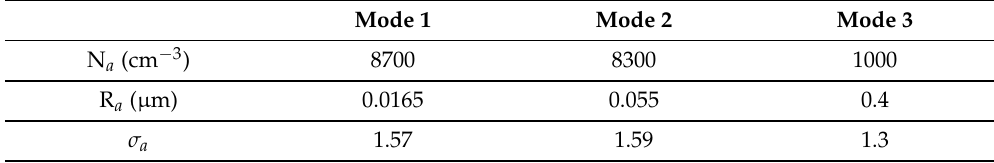
Table 2. Aerosol size distribution characteristics at 2100 (UTC) during IOP 13 used in the control simulation. N a is the number of particles, R a is their dry radius and σ a is the standard deviation of the log-normal distribution.